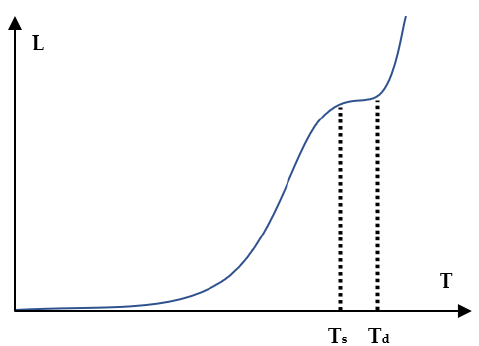
Table 3. Phase composition and mechanical properties of the ceramic samples.